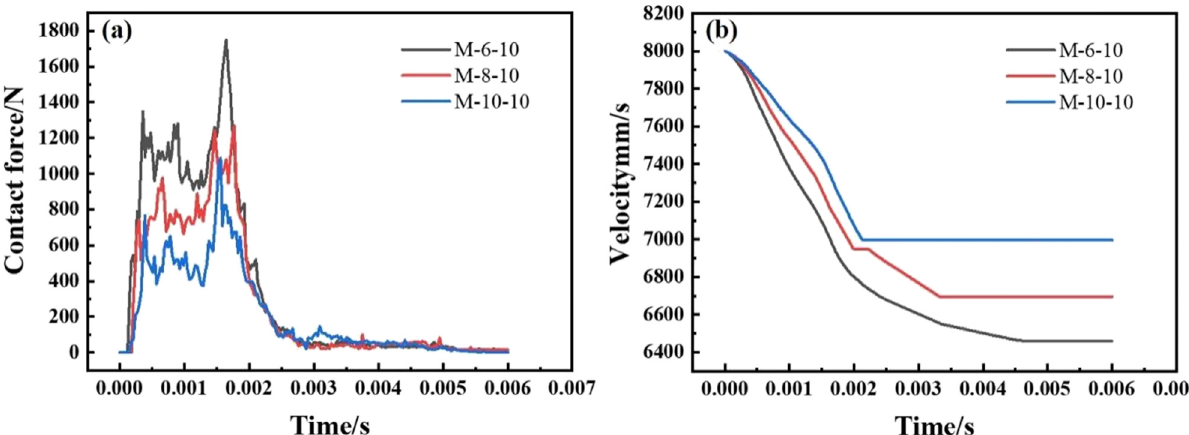
Figure 5: Comparison between contact force – time and velocity – time curves of M - 6 - 10, M - 8 - 10, and M - 10 - 10. ( a ) Contact force – time curves and ( b ) velocity – time